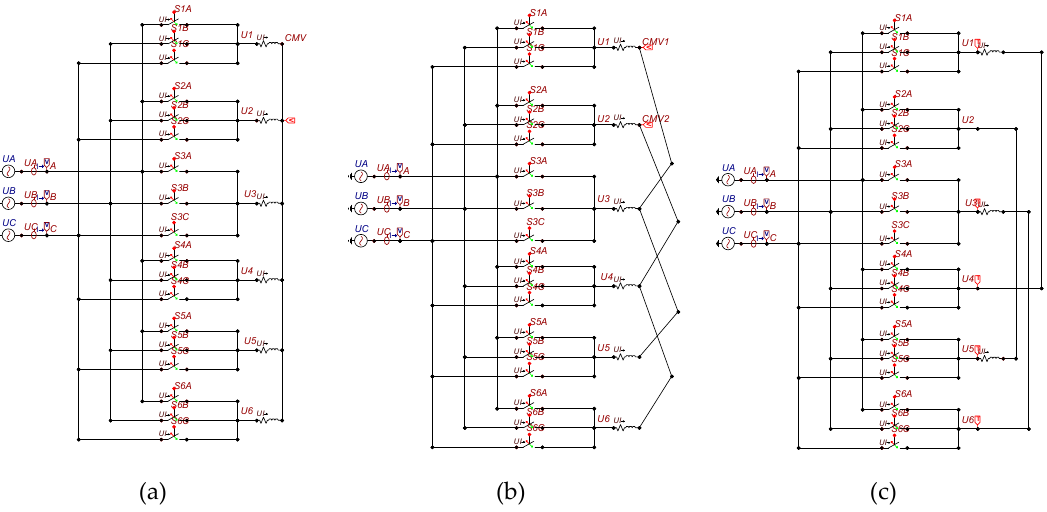
Figure 4. (a) ATP ‐ EMTP simulation models of the MC supplying six ‐ phase load, (b) six phase load Figure 4. ( a ) ATP-EMTP simulation models of the MC supplying six-phase load, ( b ) six phase load with two star points, and (c) three ‐ phase open ‐ end load. with two star points, and ( c ) three-phase open-end load.